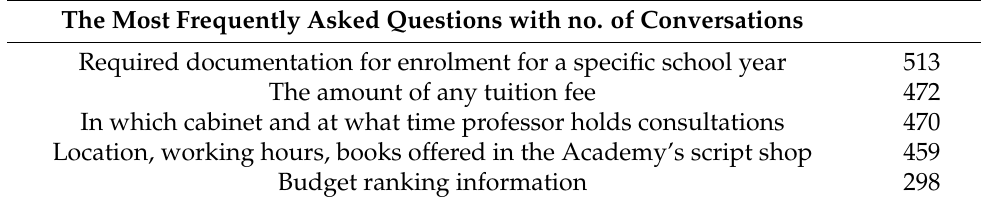
Table 2. Statistics of student inquiries in February